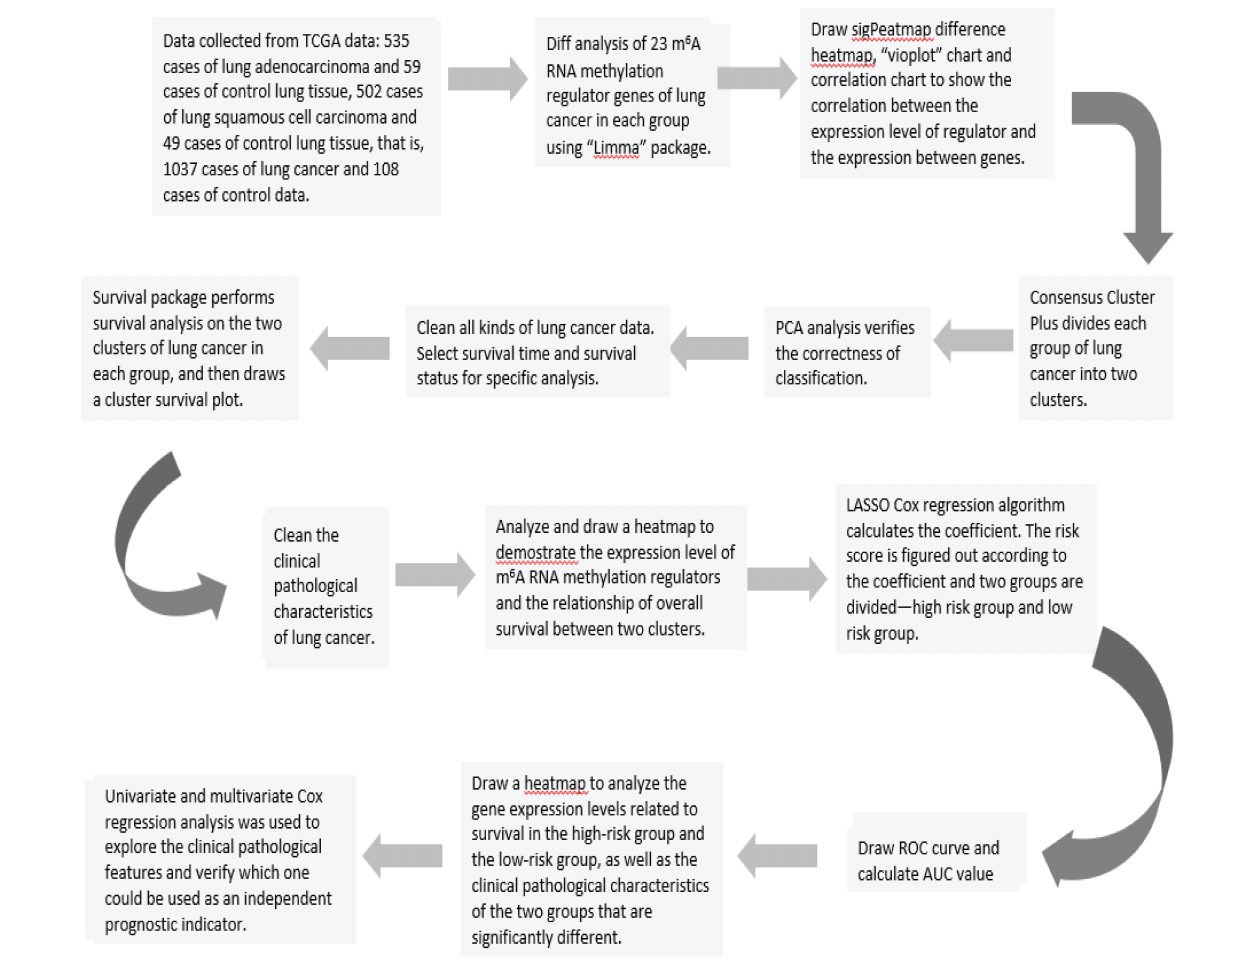
Frontiers in Cell and Developmental Biology |